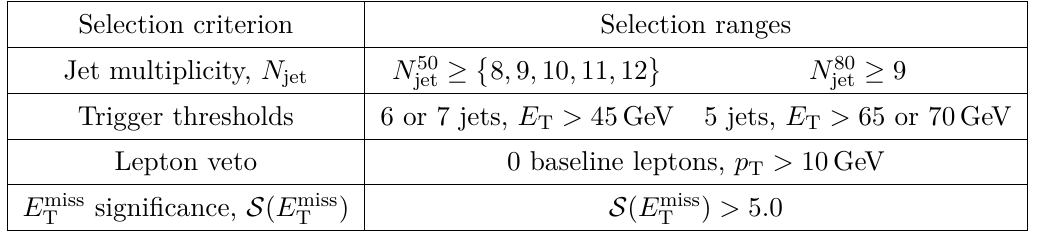
Table 6 . Summary of common selection criteria in ATLAS-CONF-2020-002, reproduced in part from sections 4 and 5 and table 1 of [1]. Variable trigger thresholds depend on year in which data were